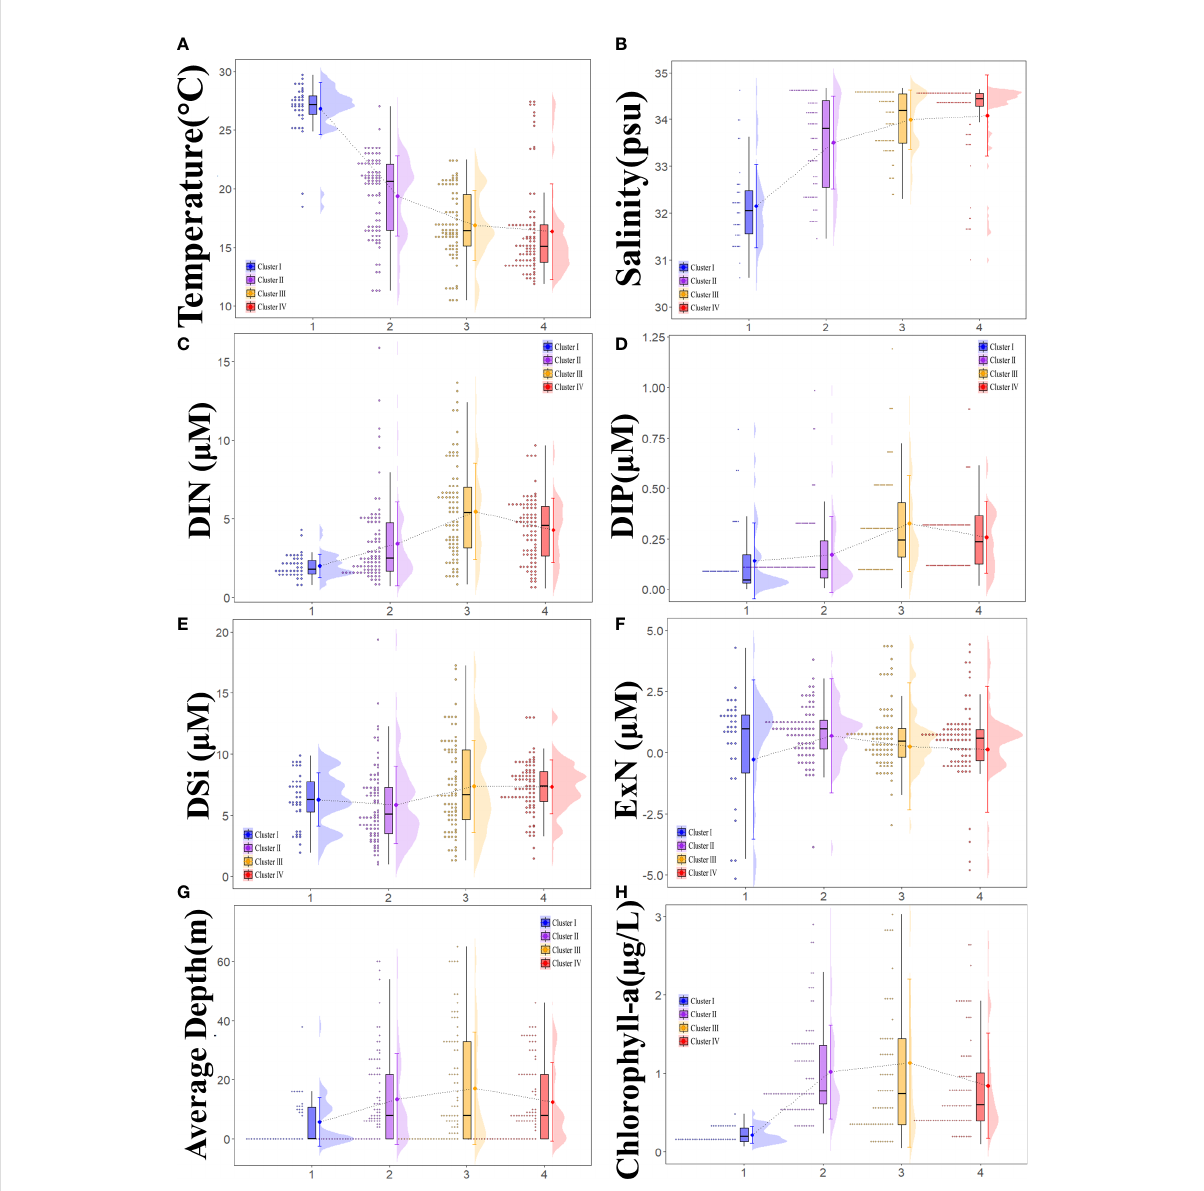
FIGURE 7 Raincloud plots of the four clusters (clusters I, II, III, and IV) concerning temperature (A) , salinity (B) , dissolved inorganic nitrogen (DIN) (C) , dissolved inorganic phosphorus (DIP) (D) , dissolved silica (DSi) (E) , excess nitrate (ExN) (F) , average euphotic depth (the average value of 100%, 30%, and 1% light depths) (G) , and average total chlorophyll- a concentrations (H) , illustrating data probability distribution (the “ cloud ” ), with jittered raw data (the “ rain ” ) supplemented by a boxplot in the middle. The dots and error bar next to the “ cloud ” represent the mean and mean range for each